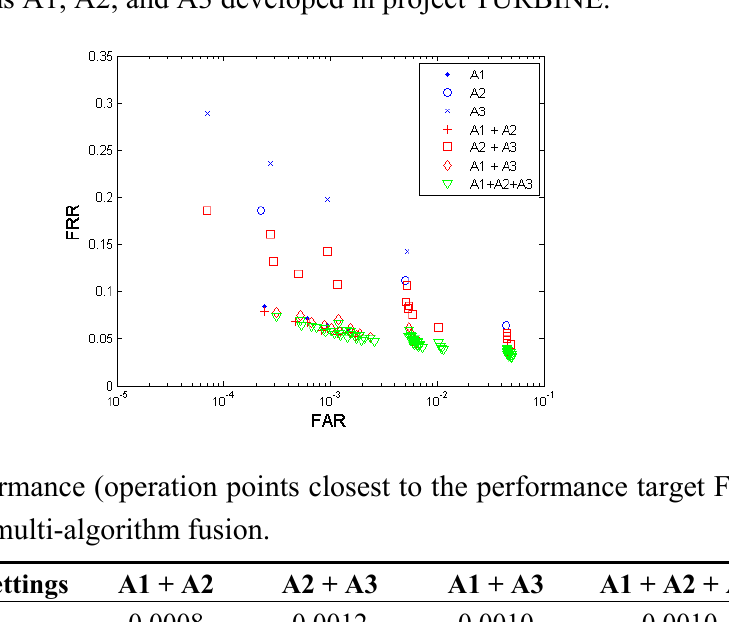
Figure 4. Multi-algorithm fusion results by the three anonymized biometric template protection algorithms A1, A2, and A3 developed in project TURBINE.